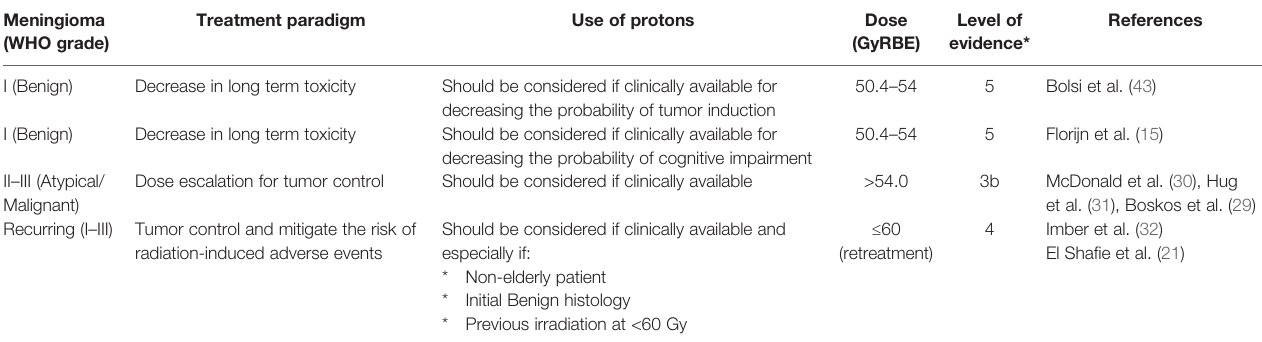
TABLE 3 | Indications for proton therapy in the management of WHO grades I – III meningioma. Meningioma (WHO